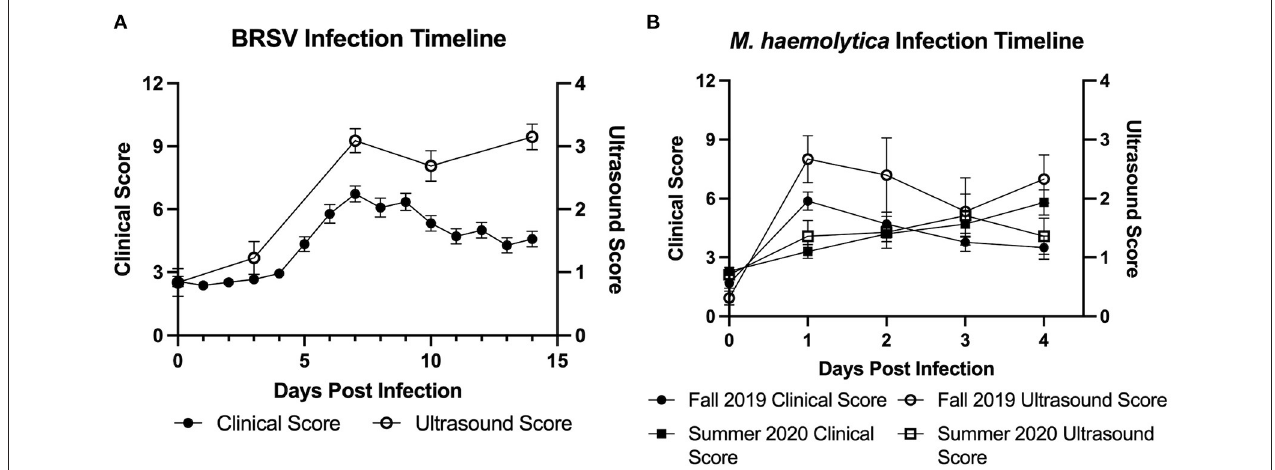
FIGURE 2 | Timeline of experimental BRSV and M. haemolytica infection. Calves were challenged with either BRSV (A) or M. haemolytica (B) . Unless clinical signs necessitated earlier euthanasia, calves challenged with BRSV were euthanized on day 14 after infection, whereas calves challenged with M. haemolytica were euthanized on day 4 after infection. All calves were assigned a clinical score each day by a trained observer based on fever, eye and nose discharge, severity of lung sounds, and ear position. All calves were assigned an ultrasound score on selected days (days 0, 3, 7, 10, and 14 in BRSV-challenged calves; all days in M. haemolytica –challenged calves) by a trained reviewer based on presence and severity of consolidated lung tissue and pleural defects such as B-lines and comet tail artifacts. Data represent mean ±